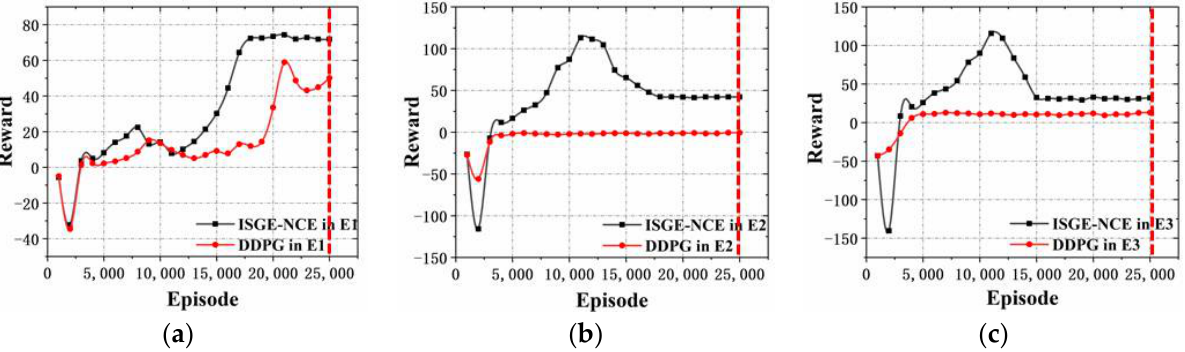
Figure 16. Comparison chart of the reward functions of the ISGE-NCE method-DDPG learning method: ( a ) comparison chart of the reward functions of the experimental environment (E1) in Section 4.1; ( b ) comparison chart of the reward functions of the experimental environment (E2) in Section 4.2; ( c ) comparison chart of the reward functions of the experimental environment (E3) in Section 4.3.